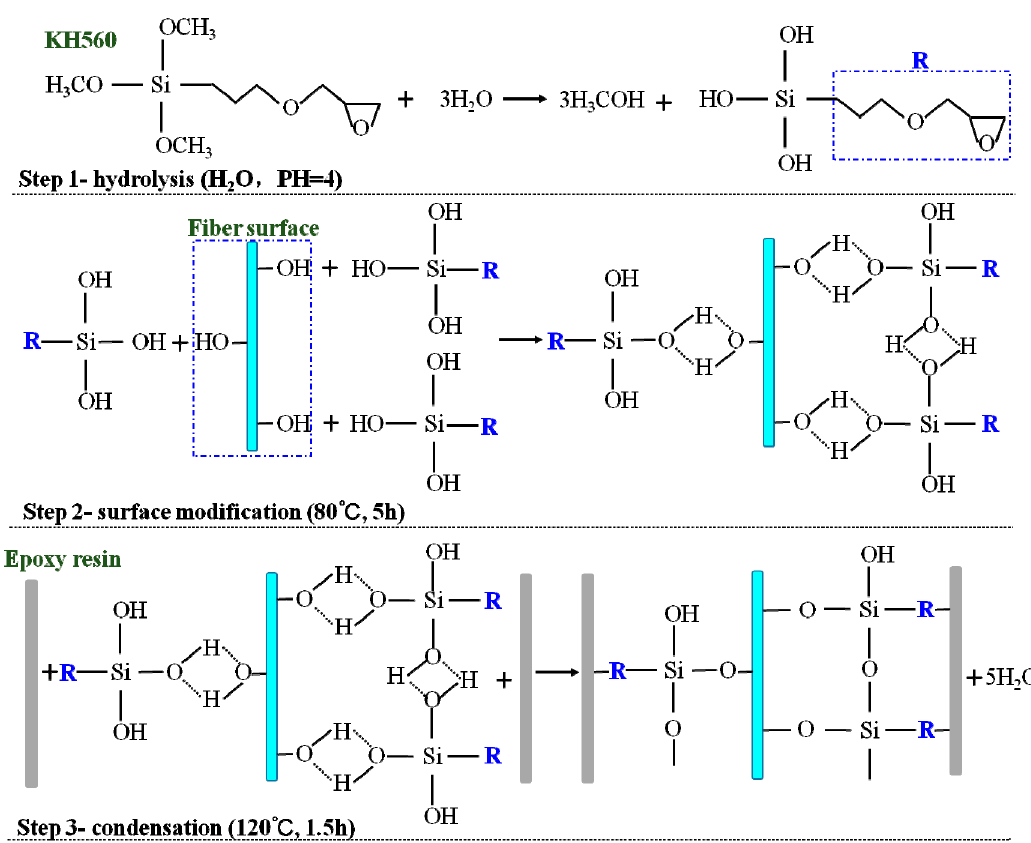
Figure 1. The schematic diagram of the KH-560 silane coupling agent modifying the surface of jute fabric.